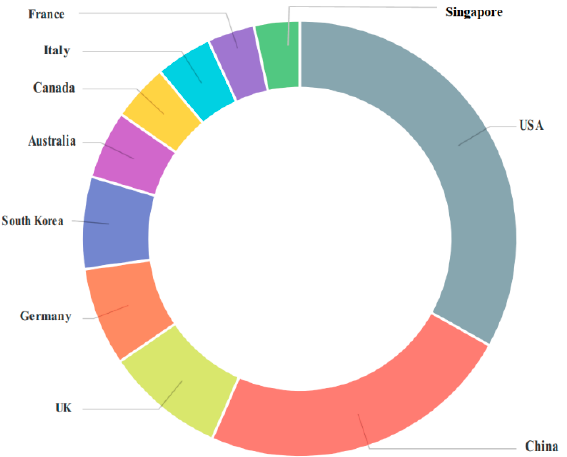
Figure 3. Shares of the total publications of the top 10 productive countries.